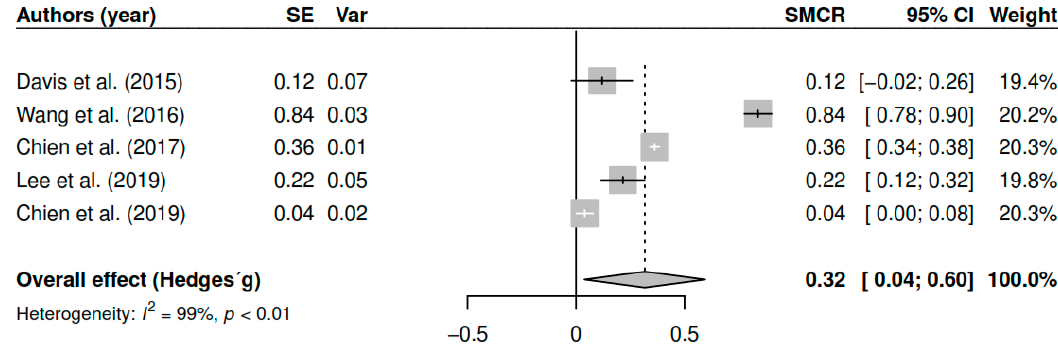
Figure 4. Forest plot for the model of random-effects and the values of Hedges’ g statistics in the positive symptoms variable (pretest–posttest).